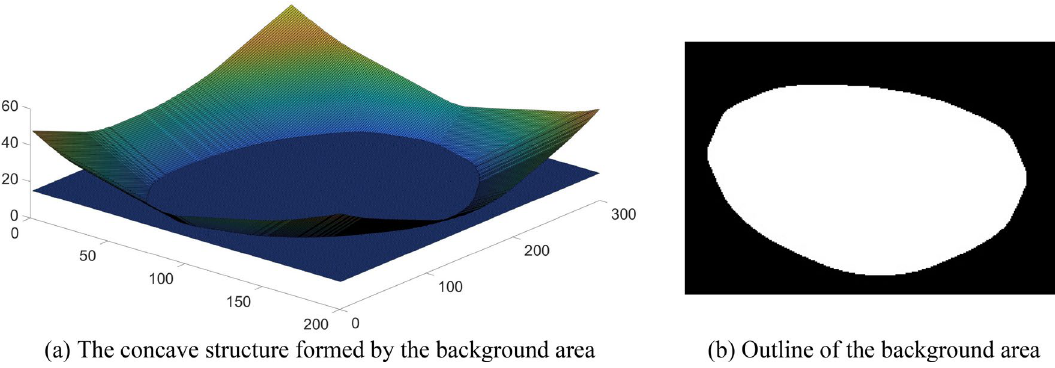
Figure 14. Recessed structure formed in the background area and 2D cross-sectional profile.